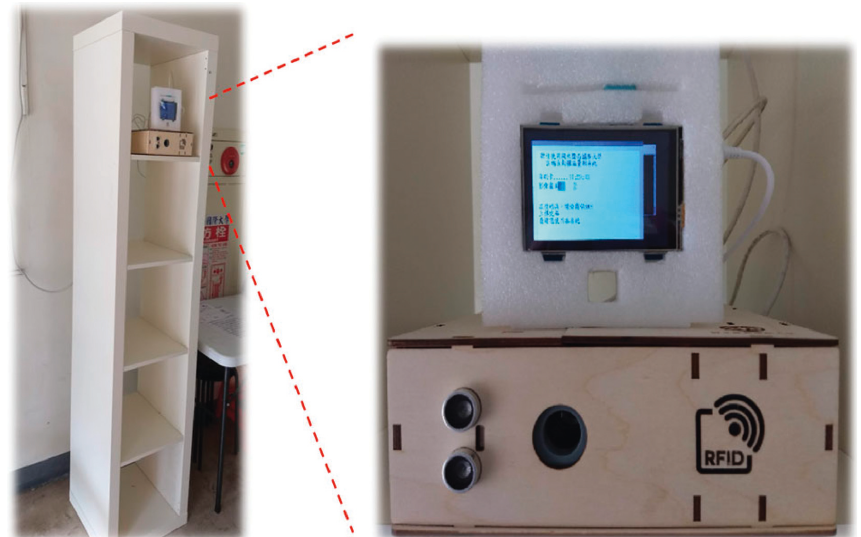
Figure 11: Station set up in the lobby of a student dormitory. The small LCD screen (left part) acts as an interactive user interface.